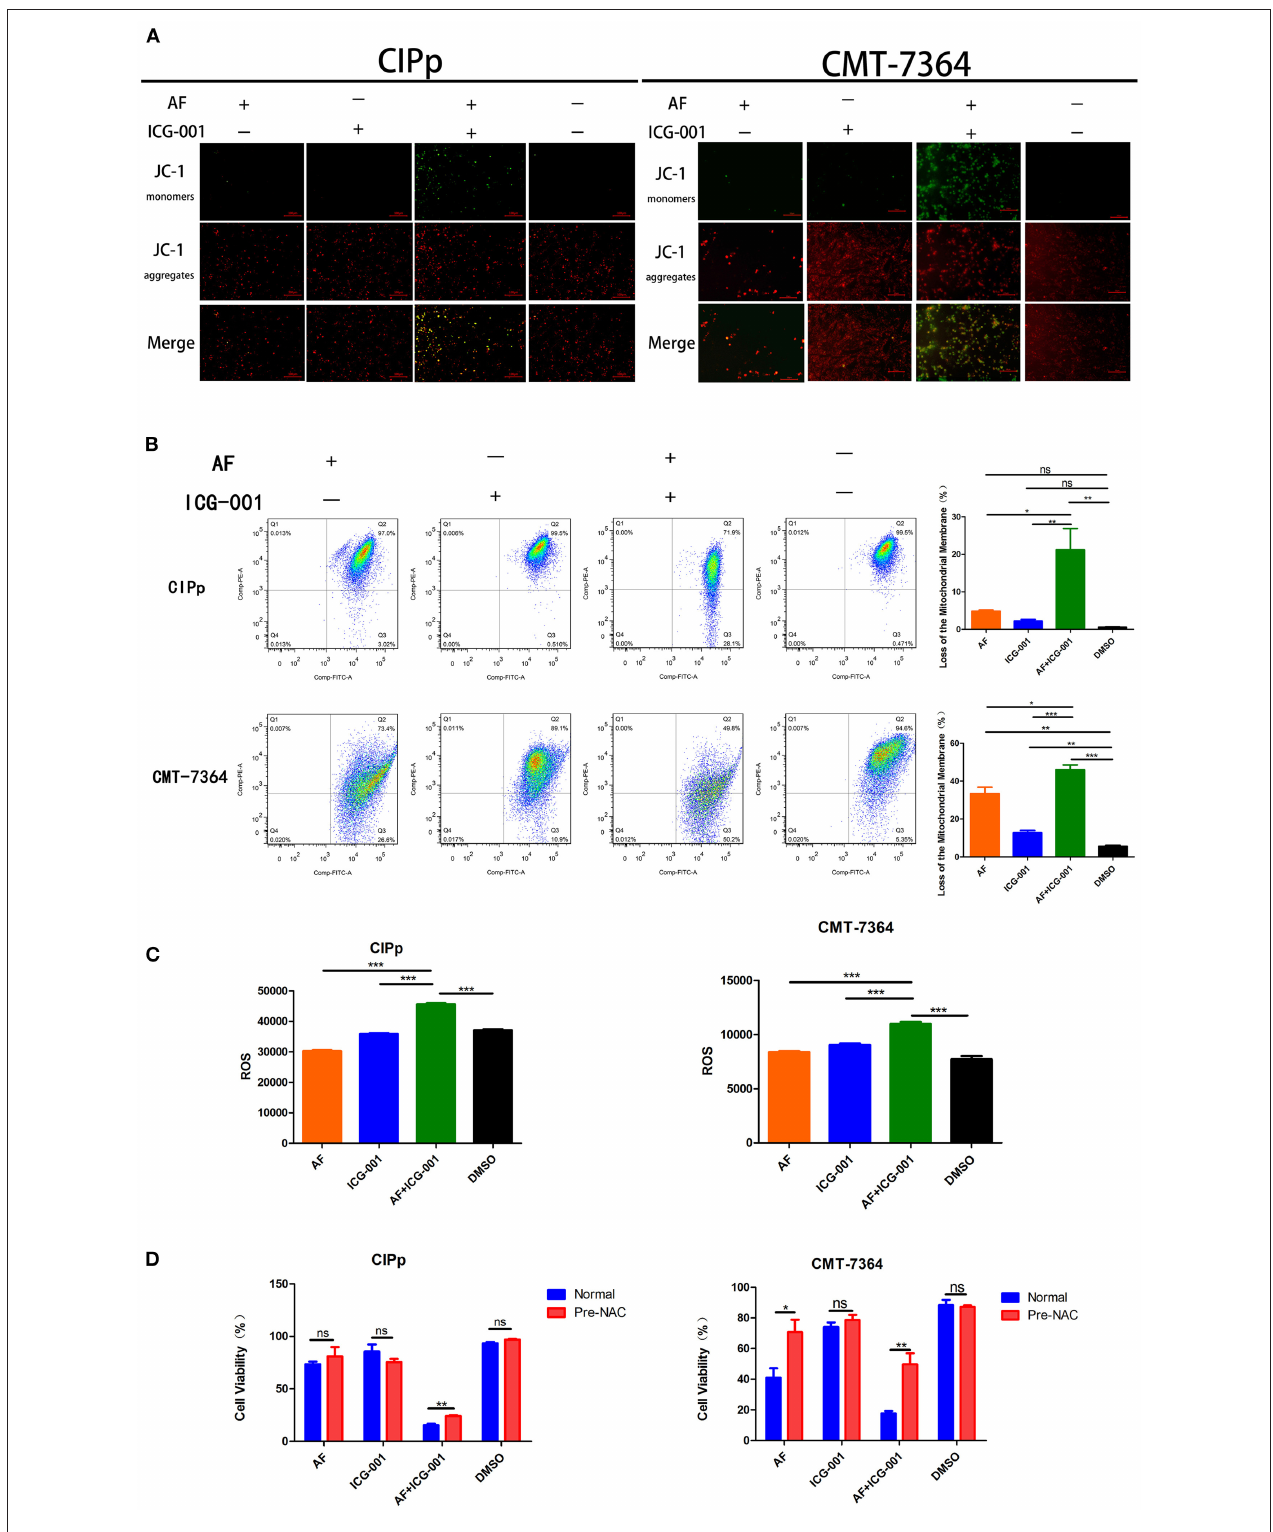
FIGURE 5 | Combination of AF and ICG-001 influences the mitochondrial membrane potential and induces ROS production. (A) Detection of mitochondrial membrane potential (MMP, 1Ψ m) of CIPp and CMT-7364 cell line by using JC-1 agent. Bar, 100 µ m. (B) The 1Ψ m of CIPp and CMT-7364 cells detected by the flow cytometry assay. (C) ROS level of CIPp and CMT-7364 cells after drug treatment. (D) Cell viability of CIPp and CMT-7364 cell lines after drug treatment (4 µ M AF, 40 µ M ICG-001, 4 µ M AF + 40 µ M ICG-001) with or without pre-NAC application. Data were representative of three independent experiments. p -values: * p < 0.05; ** p < 0.01; *** p < 0.001; ns,